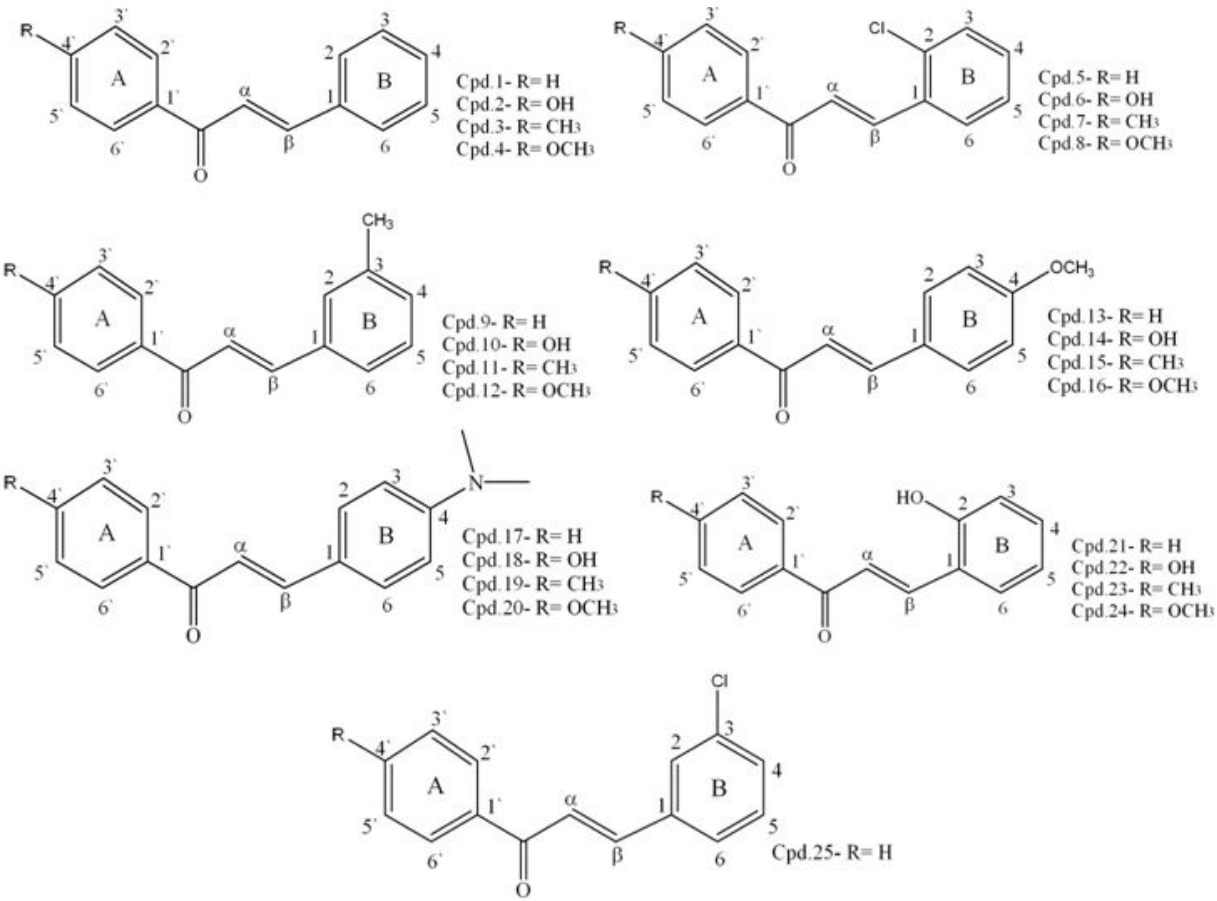
Figure 1. Structures of different chalcones synthesized in this study. ‘Cpd’ stands for an abbreviation of “Compound”.